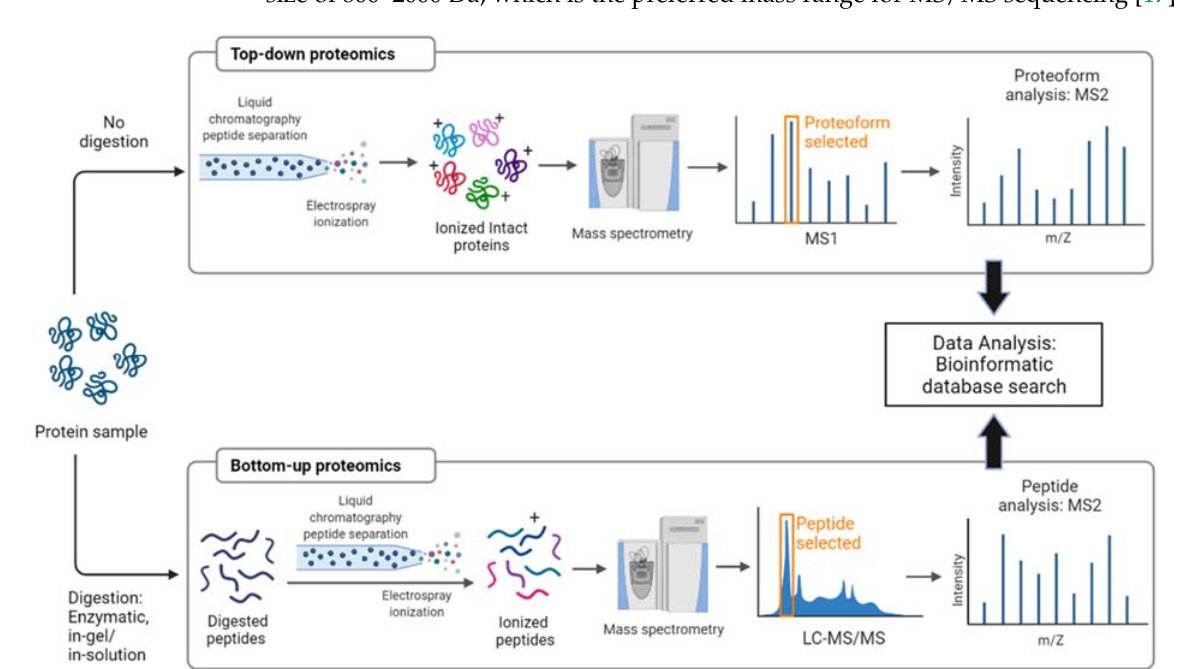
Figure 2. Schematics of top-down and bottom-up proteomics analysis.